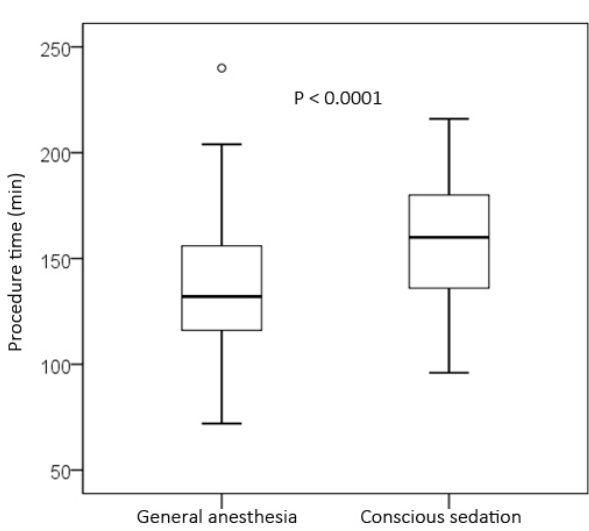
Fig. 2. Procedure time.